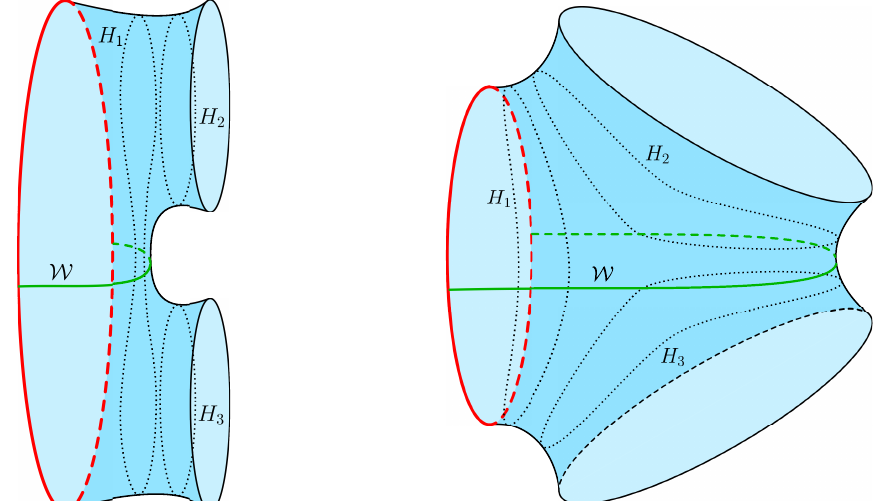
Figure 3. In the large ‘ i limit, the horizons are locally identified. There are two cases: if one length is larger than the sum of the other two, ‘ the whole of the two short horizons are identified with the long one, and the remaining parts of the long horizon are identified with each other. Otherwise, each horizon has a portion which is identified with each of the